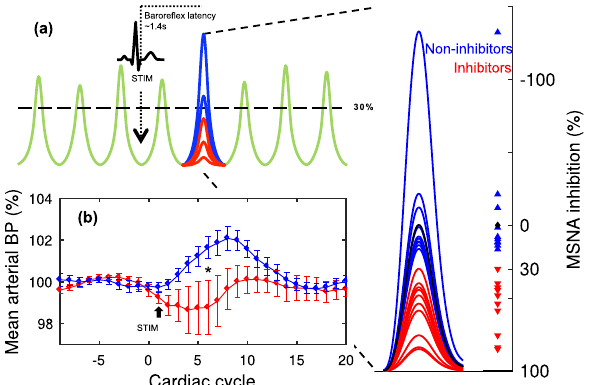
Figure 1. Microneurography and blood pressure recordings. ( a ) Schematic illustration of averaged MSNA inhibition in response to a series of arousal stimuli. The right inset presents the distribution of mean post- stimulus MSNA burst amplitudes observed in each study participant, presented as both synthetic mean bursts and a dot plot. Inhibitors are defined as those displaying an average post-stimulus reduction in mean burst amplitude (MSNA inhibition) of 30% or more following the first (unexpected) stimulus in each train (red). (b) The average mean arterial BP (lower left) is presented as a function of cardiac cycle number relative to stimulus presentation in Inhibitors (red, n = 7) and Non-inhibitors (blue, n = 8), error bars represent standard error (SEM). The stimulus train begins at cardiac cycle ‘1’, indicated by the black arrow. BP in response to arousing stimuli in Non-inhibitors is significantly higher as compared to Inhibitors during cardiac interval 6 (* p =